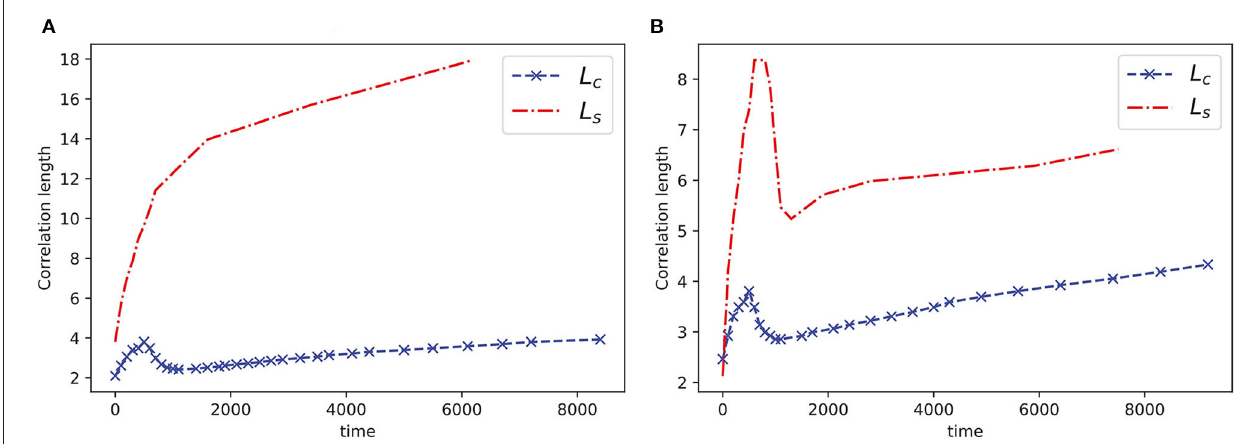
FIGURE 9 | Correlation lengths L s (top row) and L c (bottom row) as functions of time for (A) the scalar order parameter model and (B) the tensor order parameter model. The nematization correlation length is generally larger than the NP concentration correlation length. The peaks in these curves span the initial linear regime. The curve for the nematization correlation length from the scalar dynamical equations does not display a peak. Parameters R fixed through the